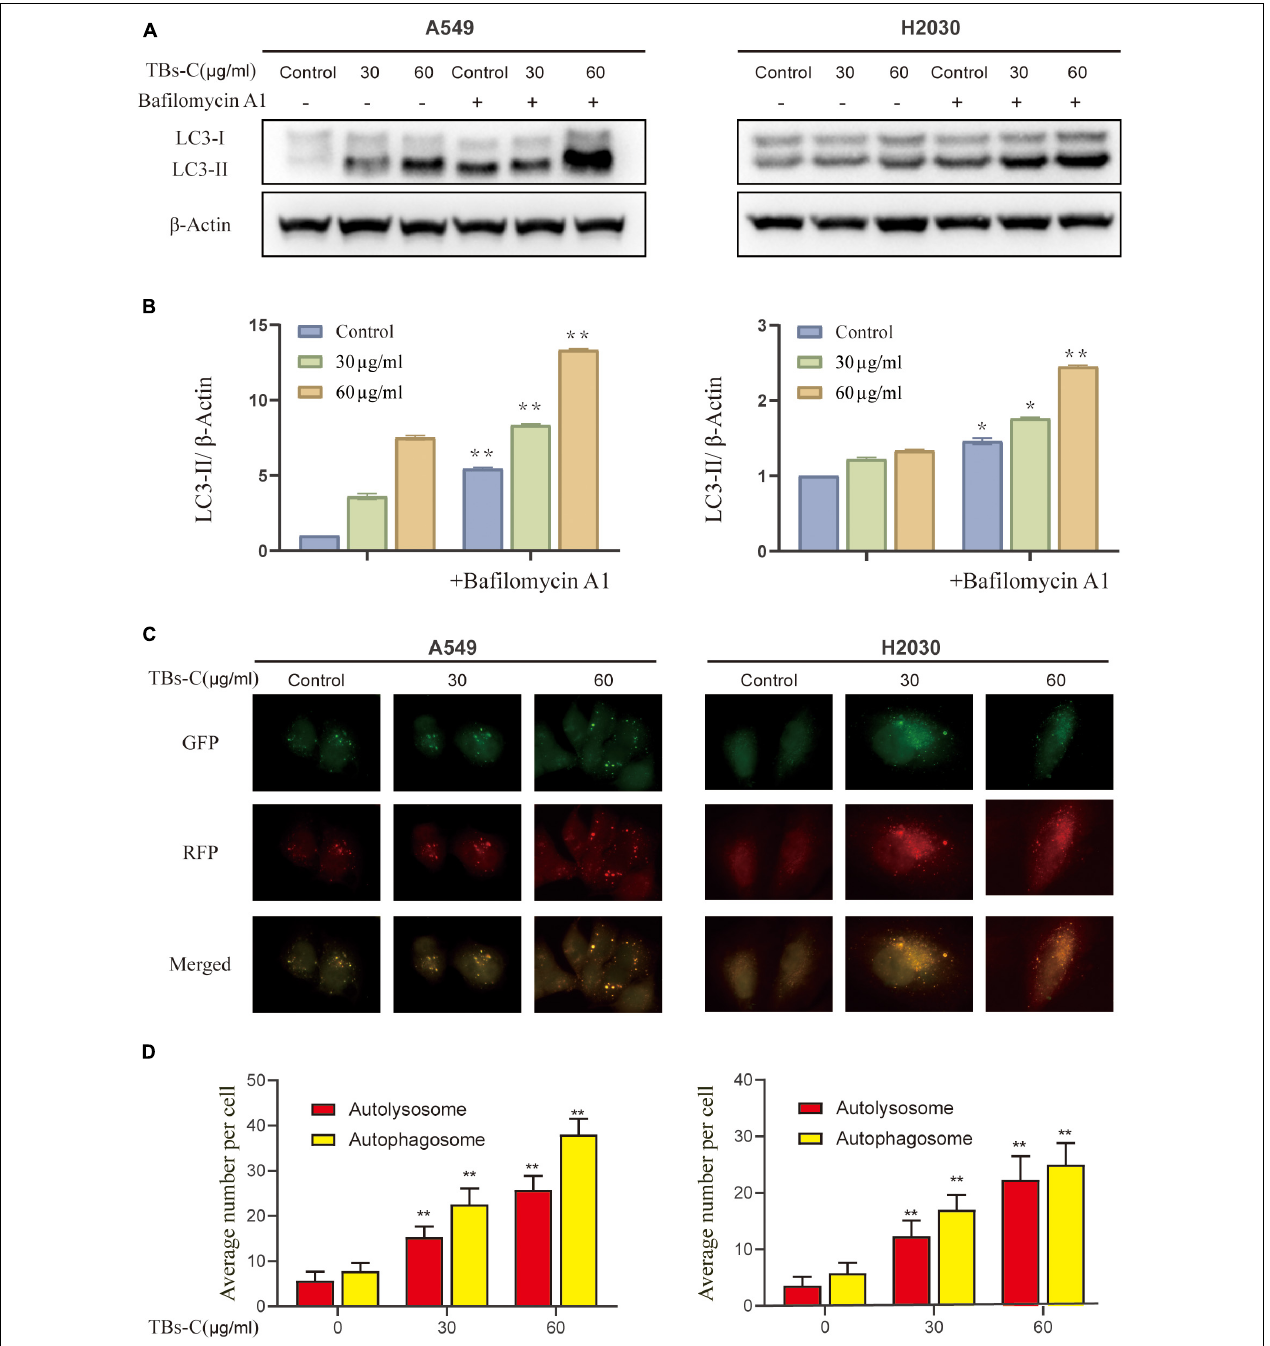
FIGURE 4 | Treatment with TBs-C promotes the autophagic flux in NSCLC cells. (A) After 24 h of treatment with different concentrations of TBs-C, the cells were treated with or without baf A1 (100 nmol/mL for 3 h), and the LC3 expression was evaluated by Western blotting. (B) Densitometric analysis of the changes in LC3-II abundance normalized to the β -actin level. (C,D) The indicated cells were transfected with the RFP-GFP-LC3B PremoTM Autophagy Tandem Sensor. Fluorescence microscopy was used to count the red and yellow puncta (Scale bar = 20 m). The number of yellow and red puncta in each cell was calculated from at least 20 cells from each group, ∗ p < 0.05, ∗∗ p <